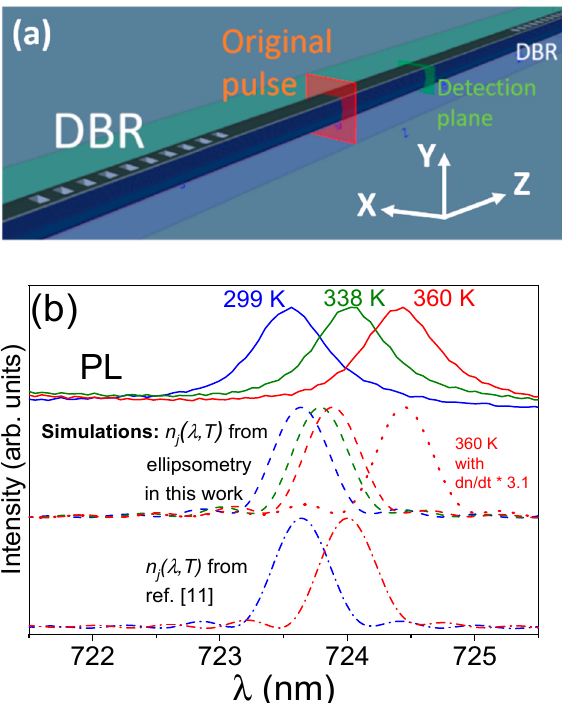
Figure 5 . ( a ) Simulation procedure, with the schematic of the OptiFDTD Designer module. The red plane is the pulse source, while the green plane is the Poynting vector detection plane. The defined axes are shown in the lower, right corner. ( b ) Comparison of normalized experimental μ -PL spectra of peak #2 at three different temperatures (solid lines) with simulations at such temperatures, using both the anisotropic, temperature-dependent refractive index calculated from ellipsometry in this work (dashed lines) and that calculated from the data by Sturm et al. [11]. Dotted line shows the resonance at 360 K by using n j ( λ , T ) obtained when multiplying by a 3.1 factor the dn/dT value calculated by ellipsometry in this work.